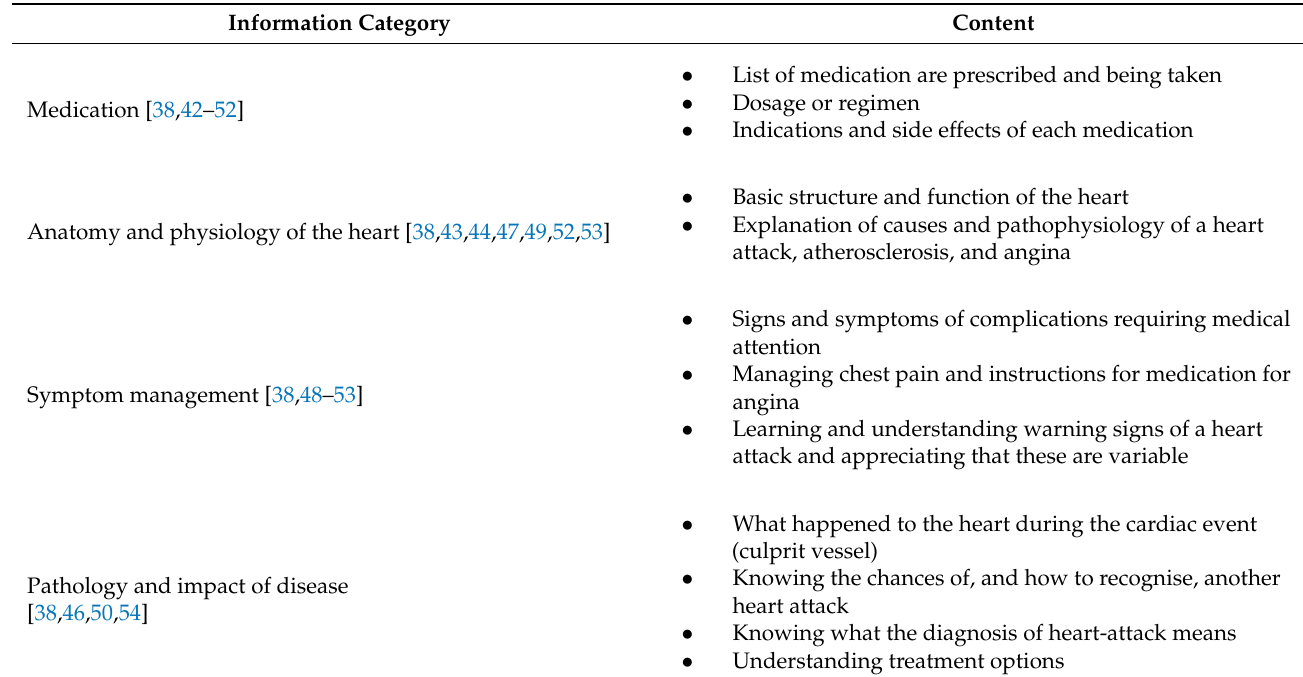
Table 1. Reported information needs for patients’ post-Myocardial Infarction (based on review findings of Scott and Thompson 2003